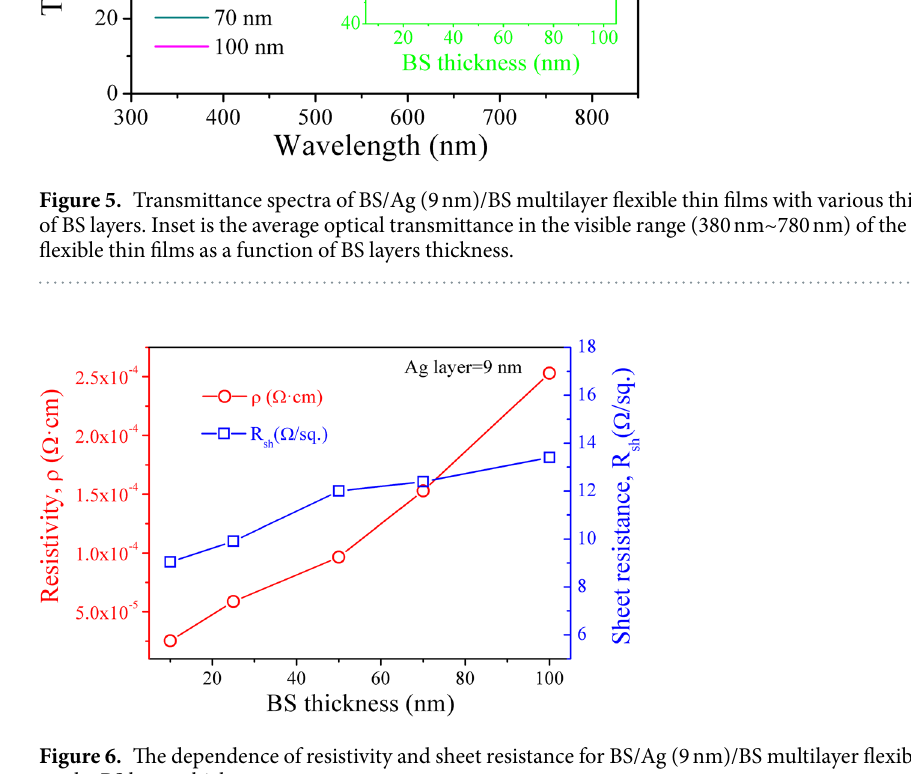
Figure 6. The dependence of resistivity and sheet resistance for BS/Ag (9 nm)/BS multilayer flexible thin films on the BS layers